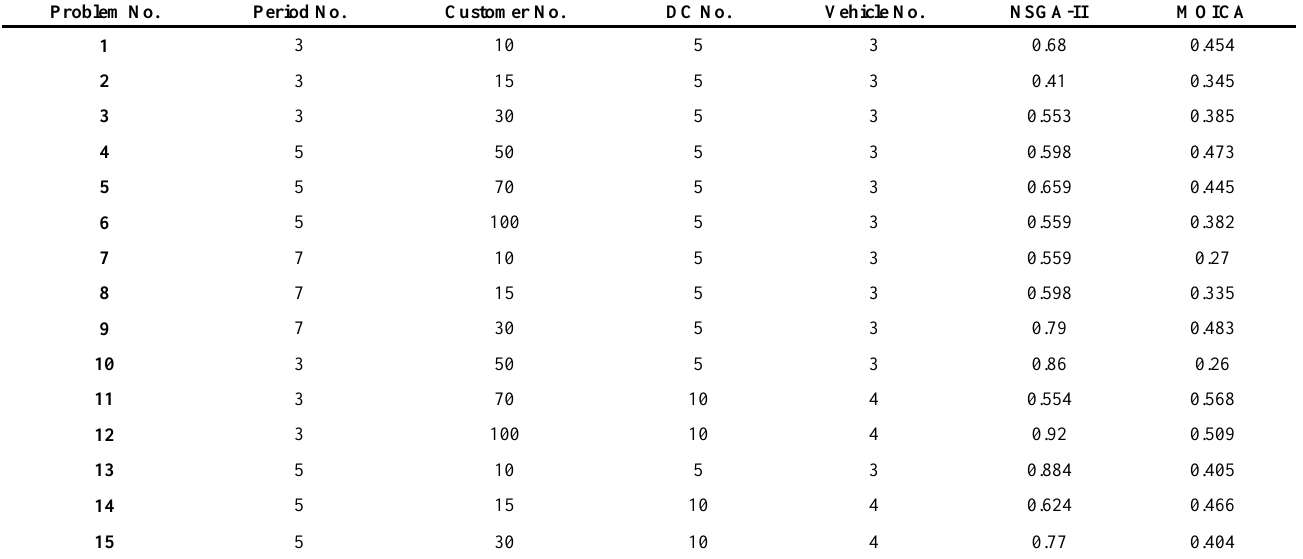
Table 4. Comparison results between the NSGA-II and MOICA according to the SM. Problem